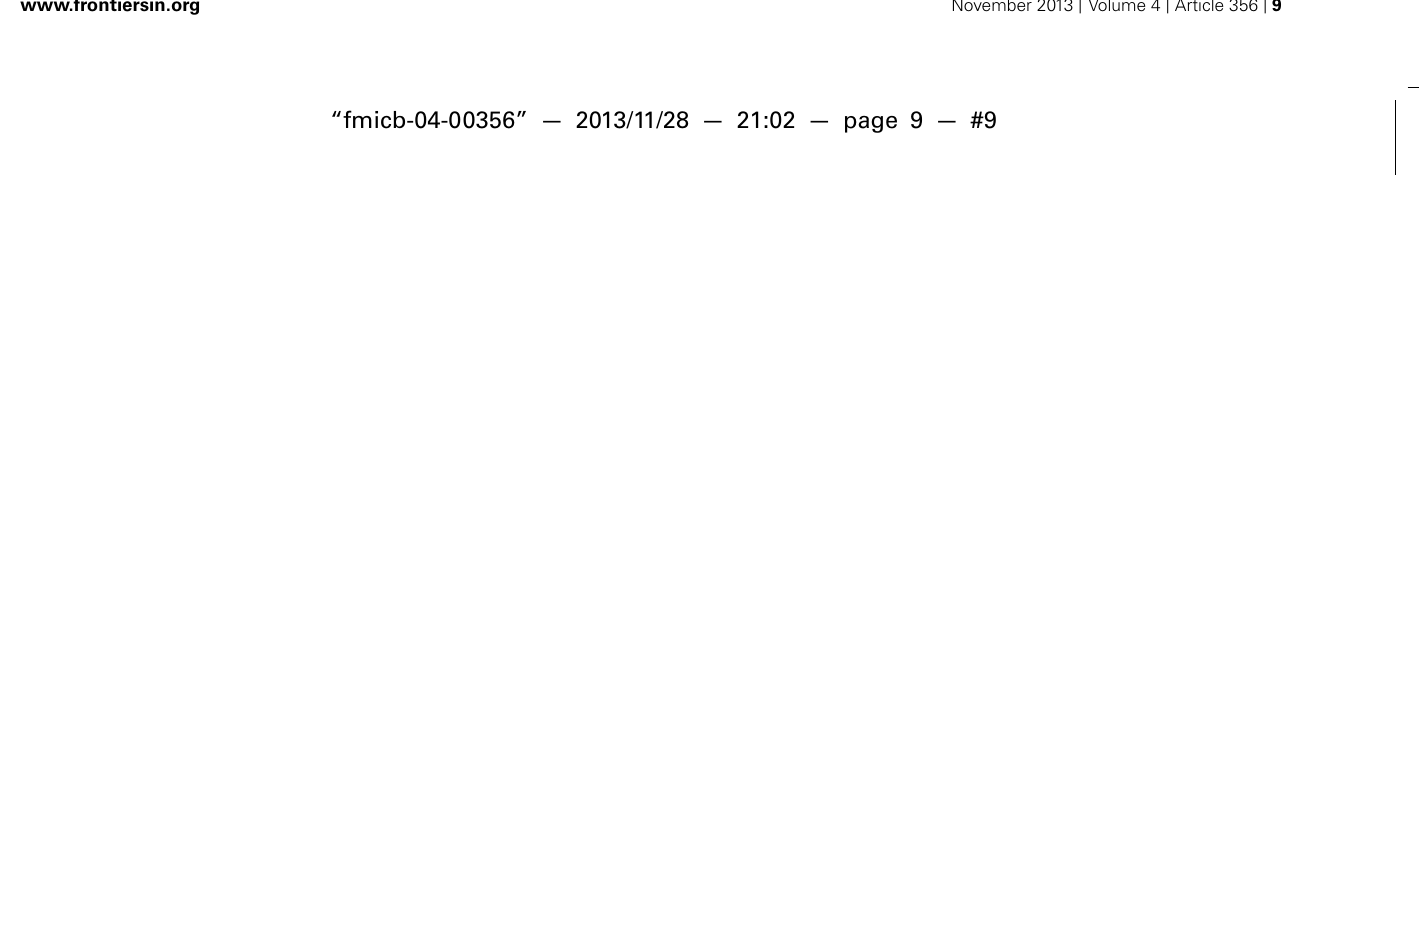
FIGURE 6 | Lux pathway controlling bioluminescence in V. fischeri. At low cell density, the sensor kinases AinR and LuxP/Q are predicted to exhibit net kinase activity leading to the phosphorylation of LuxU and subsequent phosphotransfer to LuxO. Phospho-LuxO induces the expression of the inhibitory sRNA, qrr1 , which leads to the degradation of litR mRNA. LitR is the transcriptional activator of luxR , which encodes a protein required for expression of the luxCDEBAG operon.Thus, at low cell density, litR translation is inhibited and the cells do not produce high levels of light. At high cell density, two distinct autoinducer molecules made by